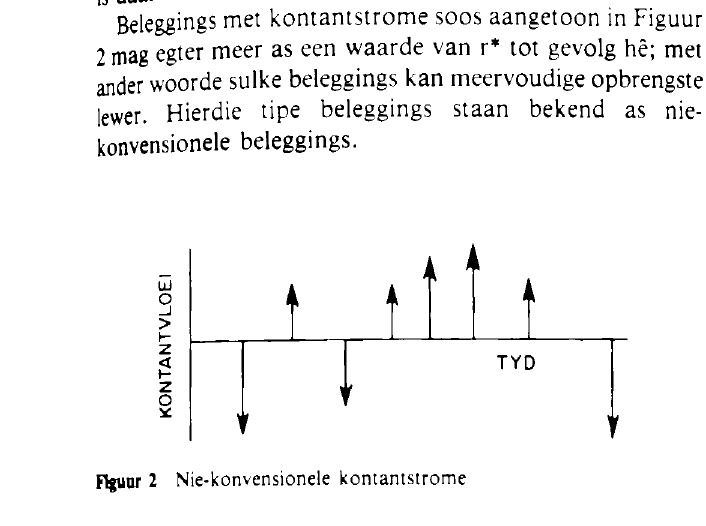
2 mag egter meer as een waarde van r• tot gevolg he;